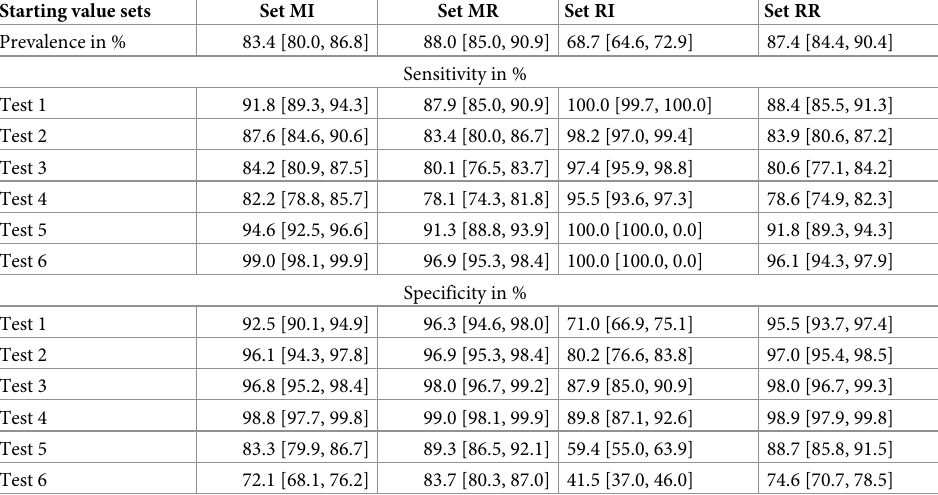
Table 4. Resulting values for the prevalence and the test accuracies for the four starting value sets for the part of the sample that is vaccinated against genotype 1 of PRRSV with confidence limits reported in brackets (rounded to one